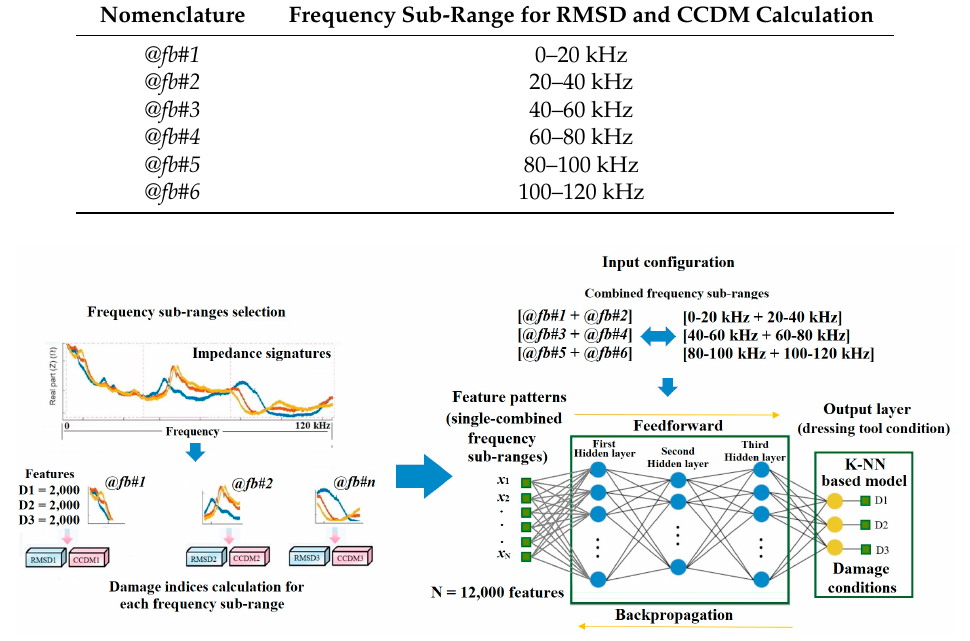
Figure 2. Intelligent dressing tool health monitoring approach based on electromechanical Figure impedance (EMI).